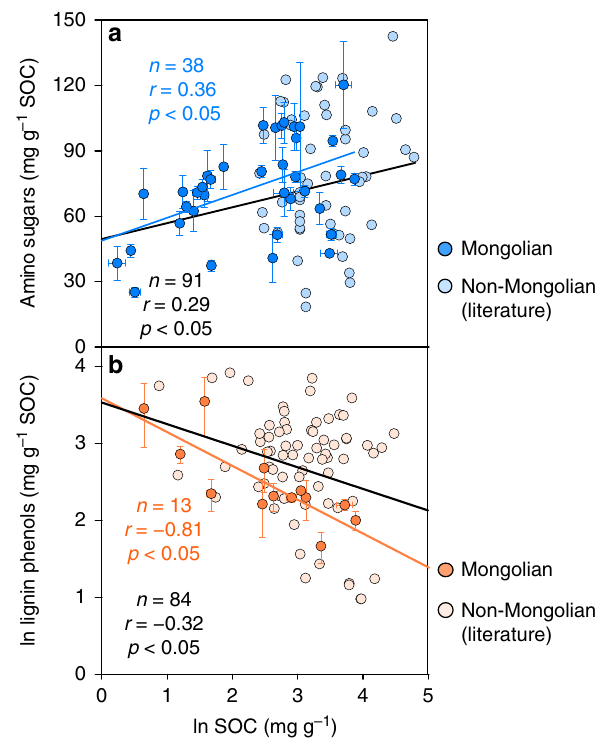
Fig. 3 Relationships between biomarker concentrations and soil organic carbon (SOC) contents. Pearson correlations between SOC-normalized concentrations of amino sugars ( a ) and lignin phenols ( b ) with SOC content in the surface soils of Mongolian (dark colored dots) and non- Mongolian grasslands (from the literature in Supplementary Data 2; light colored dots). Colored and black lines indicate linear regressions for the Mongolian and all combined data, respectively. Error bars represent